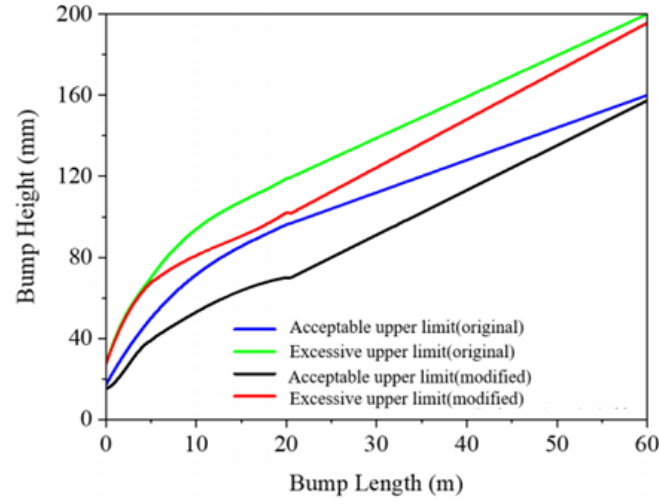
Figure 12. Comparison of modified and original Boeing Bump